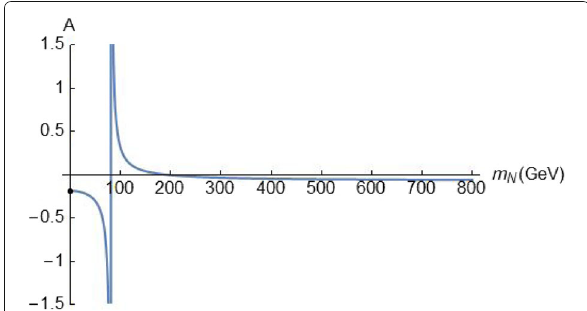
from top. And the zero point is located at top quark mass region. However, in SM, such an effect is not appear as this Feynman diagram does not appear individually. • When sterile neutrino mass is larger than electroweak scale, the behavior is asymptotic stable, giving a value smaller than SM. Since we are only interested in GeV scale sterile neutrino, such a range will not be involved in this paper.